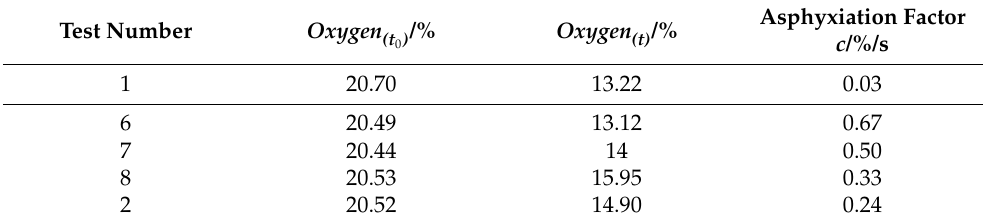
Table 9. Asphyxiation efficiency of nitrogen injection at different pipe diameters.